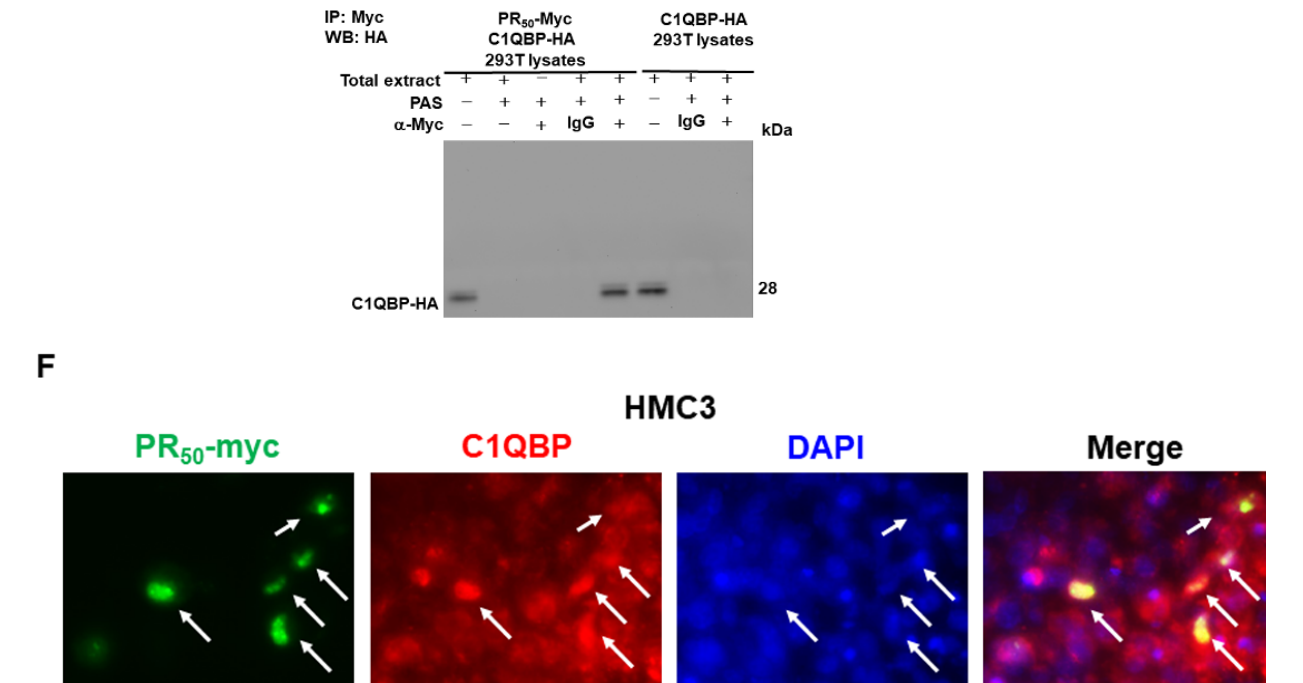
Figure 5. Complement component 1 q subcomponent-binding protein (C1QBP) is one of the specific interaction partners of the PR 50 protein. ( A ) The flowchart displays the yeast two-hybrid strategy for screening human HMC3 microglial cells’ cDNA library using PR 50 as bait. ( B ) Clones in the screening plate containing the C1QBP fragment are shown (red arrows). Blue diploid cells contain four reporter genes that are activated in response to two hybrid interactions. ( C ) Schematic drawing of the overlapping C1QBP cDNA clones that span the coding region of the C1QBP gene (NCBI reference sequence: NP_001203). C1QBP contains a mitochondrial glycoprotein MAM33-like domain. ( D ) Confirming the interaction between PR 50 and full length C1QBP using yeast two-hybrid assay. Diploid cells containing BD-p53 and AD-T were used as a positive control. ( E ) PR 50 interacts with C1QBP in an immune co-precipitation (co-IP) analysis. 293T cells were co-transfected with pCMV-PR 50 -myc and pCMV-C1QBP-HA. The cells were then lysed and co-immunoprecipitated with anti-myc antibody or anti-HA antibody, respectively. Finally, PR 50 and C1QBP were identified on co-IP complexes with anti-HA antibody or anti-myc antibody by western blotting. Similarly, we co-transfected 293 T cells with pCMV-C1QBP-myc and pCMV-PR 50 -HA for co-IP. The cells were then lysed and co-immunoprecipitated with anti-HA antibody or anti-myc antibody, respectively. Finally, C1QBP and PR 50 were identified on co-IP complexes with anti-myc antibody or anti-HA antibody by Western blotting. 293T cells were transfected with pCMV-C1QBP-HA as a negative control of co-IP. ( F ) PR 50 (green) and C1QBP (red) are partially co-located in the nuclei of HMC3 cells by immunofluorescence staining analysis (white arrows). The nuclei were stained with DAPI.